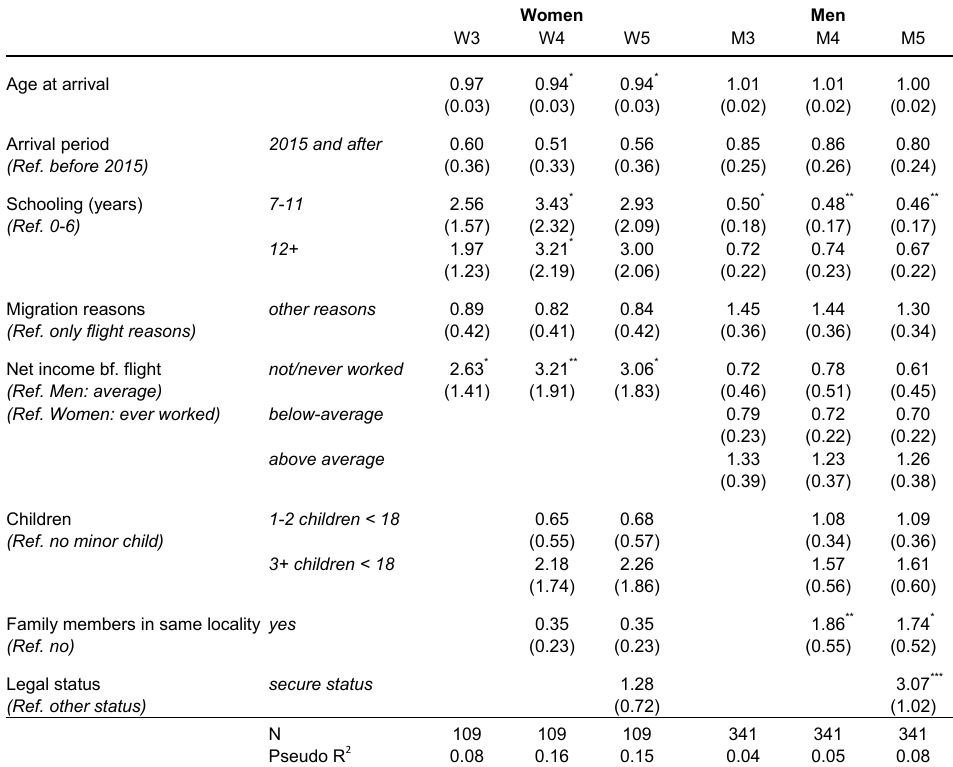
Logistic regression models predicting reunification at destination within one year of arrival (versus not reunified) by sex (step 2); odds